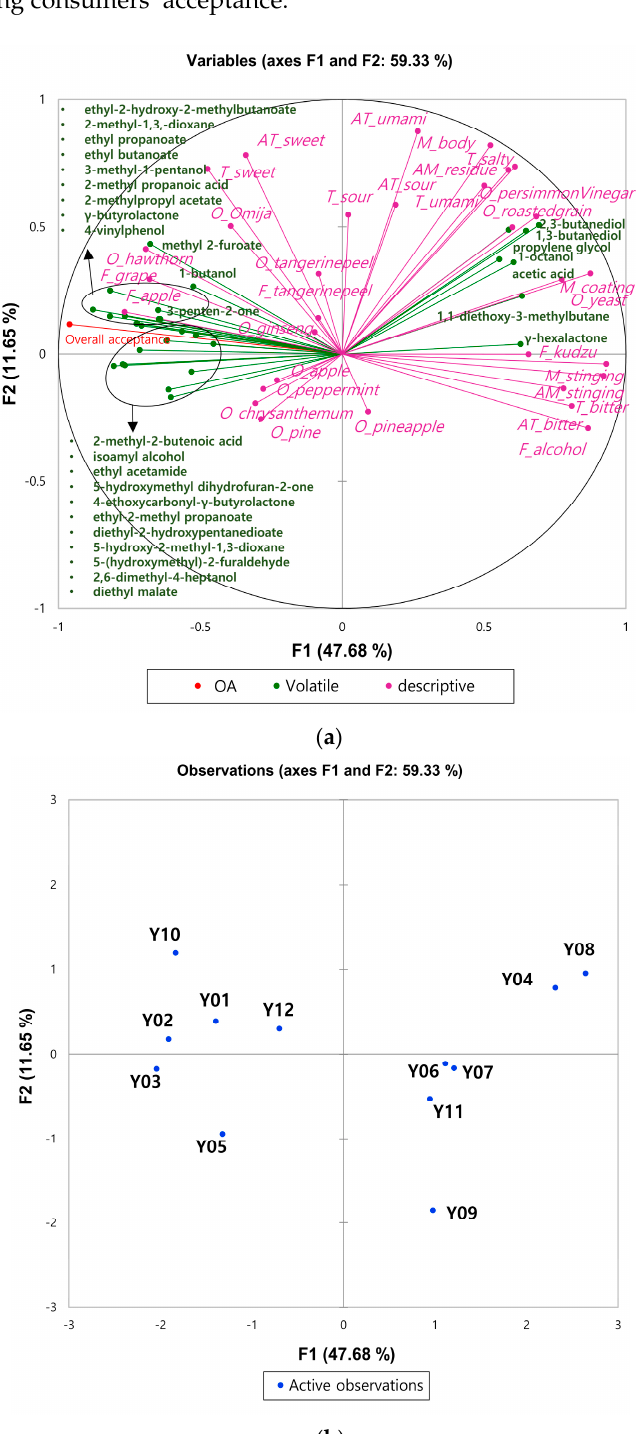
Figure 2. Correlation map of ( a ) descriptive attributes (magenta: O, odor; T, taste; F, flavor; M, mouthfeel; AT, aftertaste; AM, after-mouthfeel), volatile compounds (green) and consumers’ acceptance (red) and ( b ) yakju samples in the first two dimension of MFA.